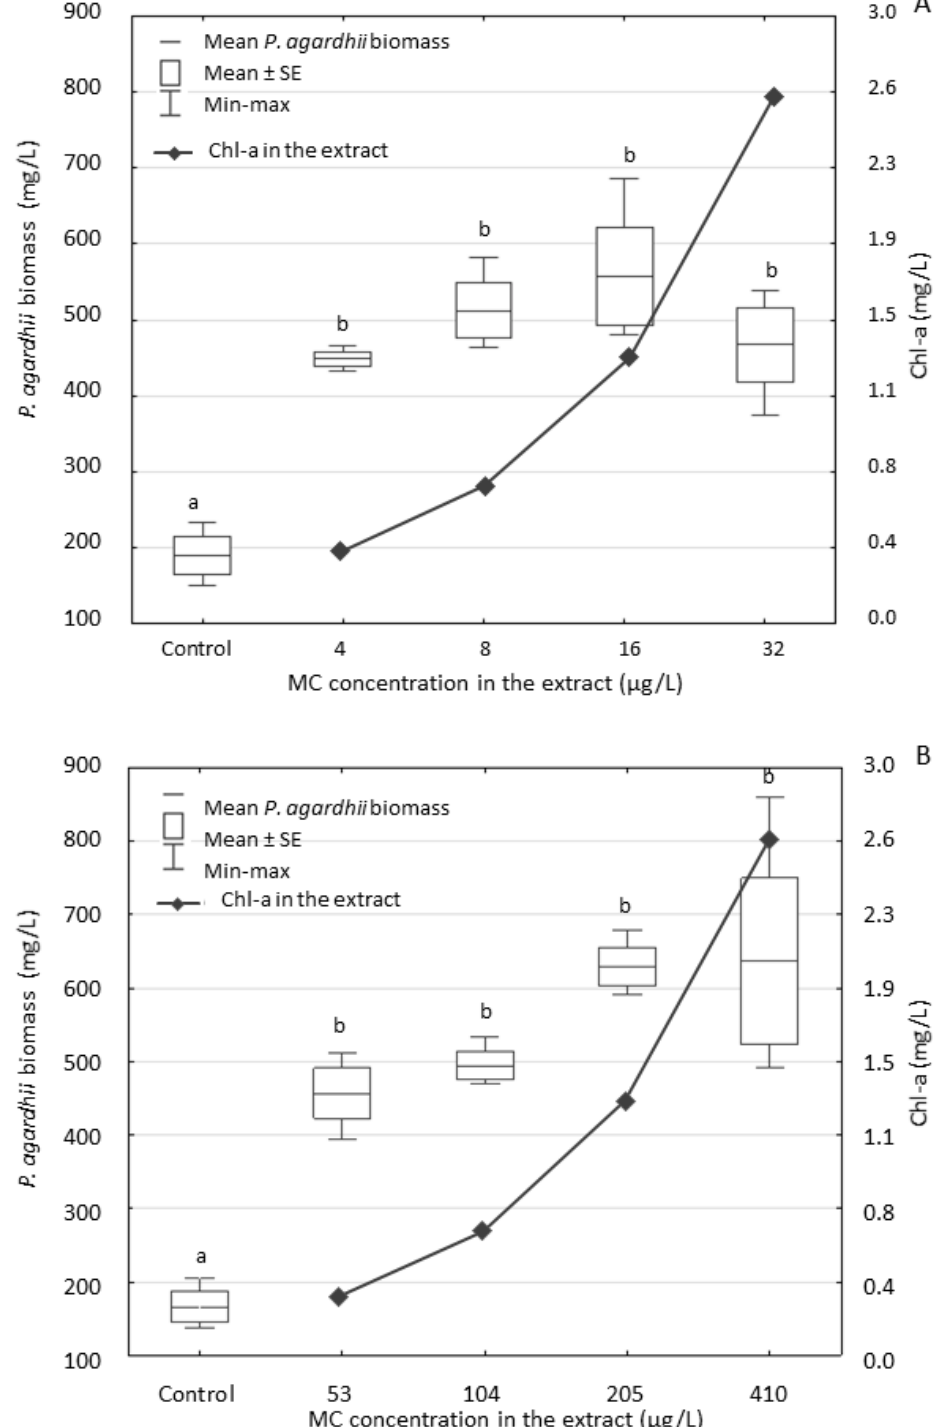
Figure 2. The biomass of P. agardhii after the seven-day exposure to the extracts Pa-A ( A ) and Pa-B ( B ) originally containing di ff erent concentrations of MCs. Both extracts dilutions had similar concentration of Chl-a. Data are expressed as means ± SE, n = 3. Di ff erent lowercase letters (a,b) indicate statistically significant di ff erences in P. agardhii biomass between experimental treatments (ANOVA, Tukey’s test, p < 0.05).